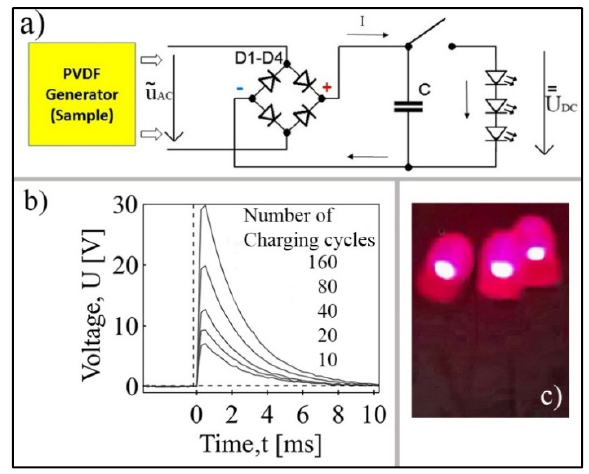
Figure 4. Energy harvesting. ( a ) Graetz bridge with storage capacitor, ( b ) discharge of stored voltage for different number of impact cycles, part ( c ) light flash of three LED diodes connected in a series after 20 impact cycles.